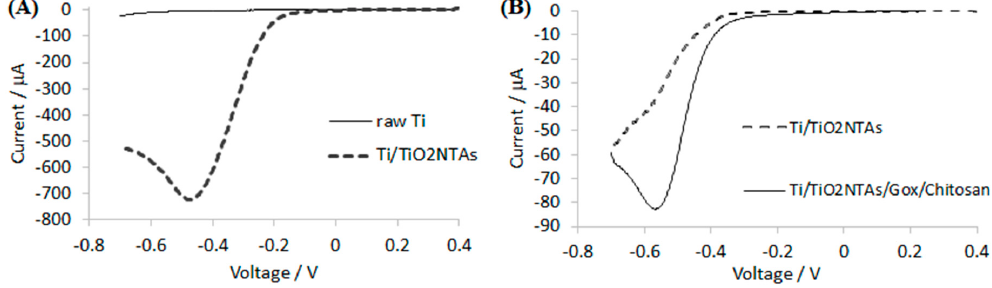
Figure 3. Linear sweep voltammograms of ( A ) Ti and Ti/TiO 2 NTAs sensors in PBS with 5 mM H 2 O 2 and ( B ) Ti/TiO 2 NTAs sensor and Chitosan–GOx/TiO 2 NTAs/Ti biosensor in PBS with 5 mM glucose. Scan rate: 100 mV·s − 1 .